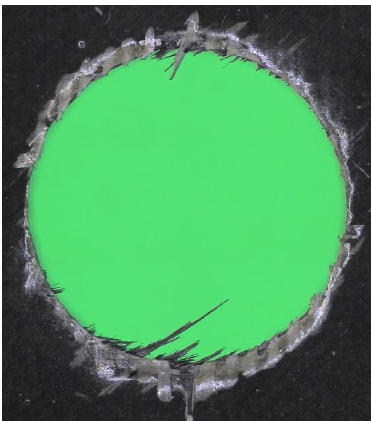
Figure 2. Carbon Fibre reinforced plastic (CFRP) drilled hole exit damage: delamination, spalling and uncut fibres.